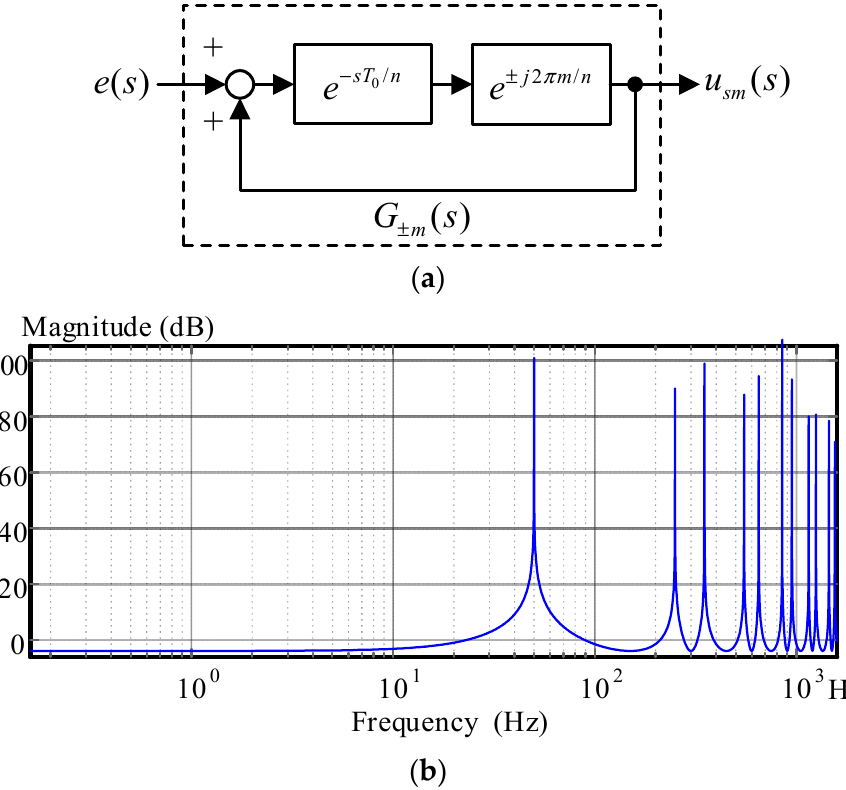
Figure 7. Continuous time-domain selective harmonic generator: ( a ) internal model; ( b ) spectrum at 50 Hz.